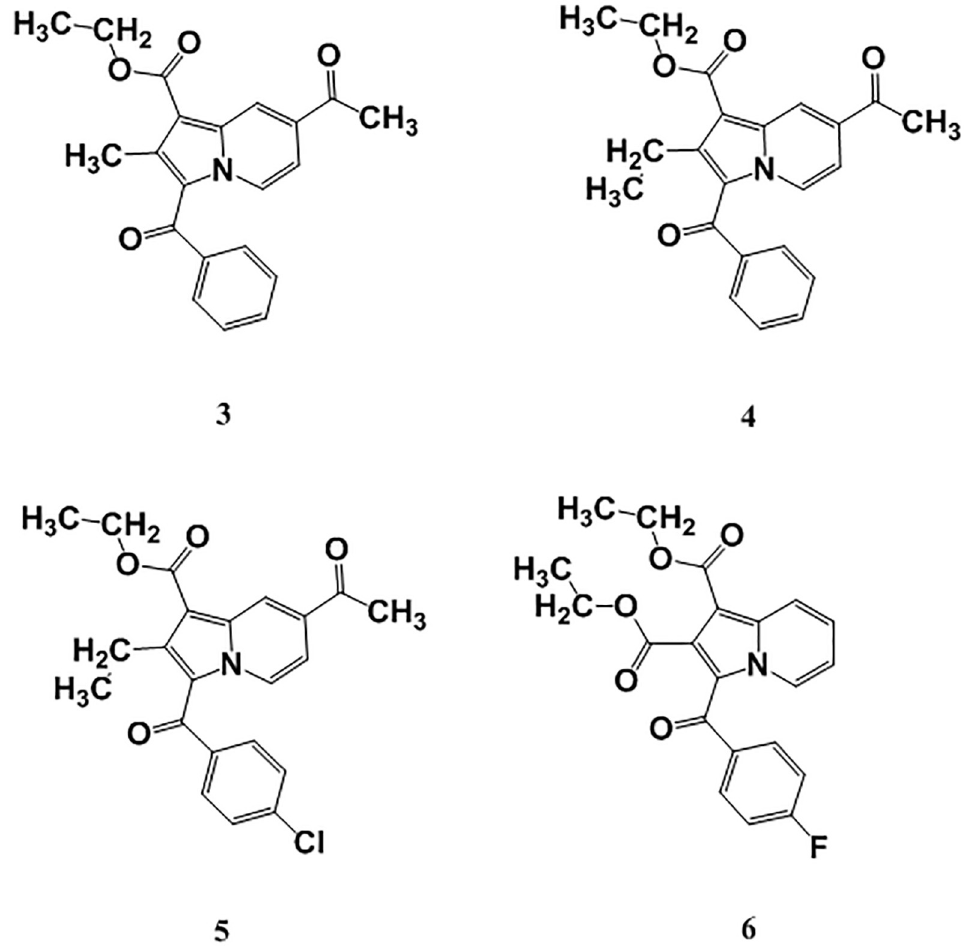
Fig 2. Molecular structure of compounds ethyl 7-acetyl-3-benzoyl-2-methyl-indolizine-1-carboxylate (3), ethyl 7-acetyl-3-benzoyl-2-ethyl-indolizine-1-carboxylate (4), ethyl 7-acetyl-3-(4-chlorobenzoyl)-2-ethyl-indolizine- 1-carboxylate (5), and diethyl 3-(4-fluorobenzoyl)indolizine-1,2-dicarboxylate (6) for their anti-TB activity against MDR strains of MTB